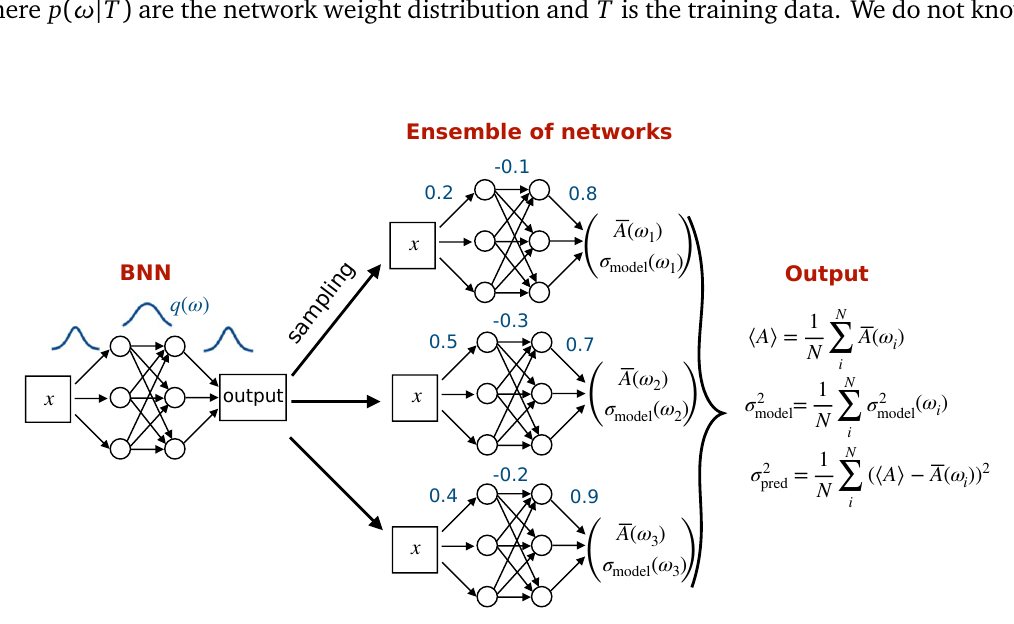
Figure 1: Illustration of the Bayesian